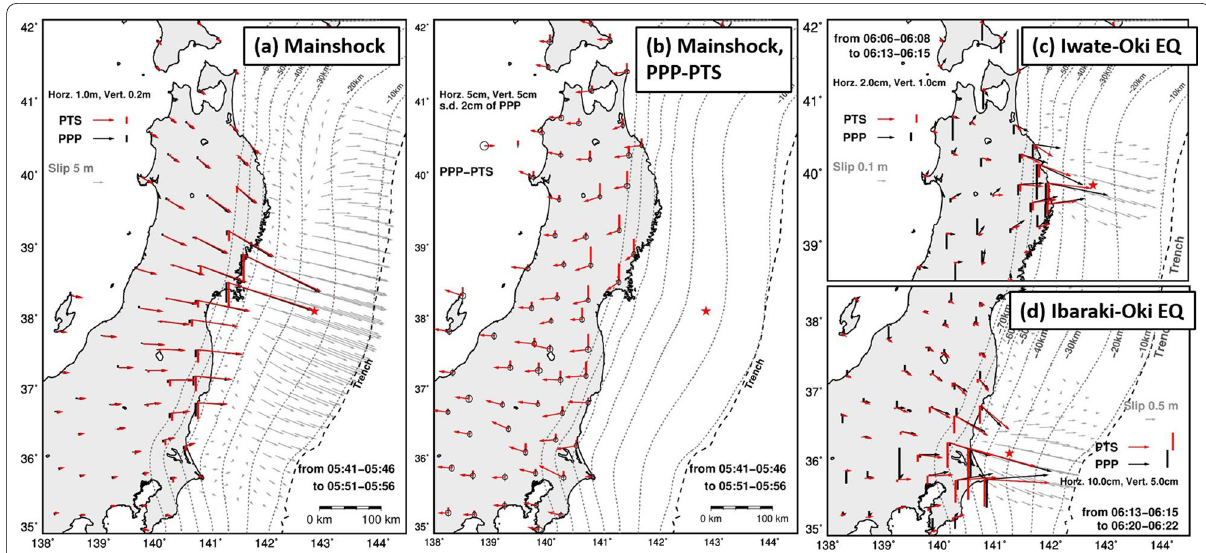
Fig. 6 Surface displacement field calculated from the estimated coseismic slip distribution. Figures show the results for the mainshock ( a ), the Iwate-Oki EQ ( c ), and the Ibaraki-Oki EQ ( d ). Red arrows and bars in each figure represent the horizontal and vertical displacements from the PTS. Black symbols refer to kinematic precise point positioning (PPP) analysis. In the case of the mainshock, the residual displacement between PPP and PTS is represented by red symbols ( b ). The red star and gray arrows in each figure represent the epicenter and the estimated slip of the respective earthquake. Error bars and ellipses that indicate the standard deviation of the PPP time series (2- σ ) just before the mainshock are attached for comparison in ( b